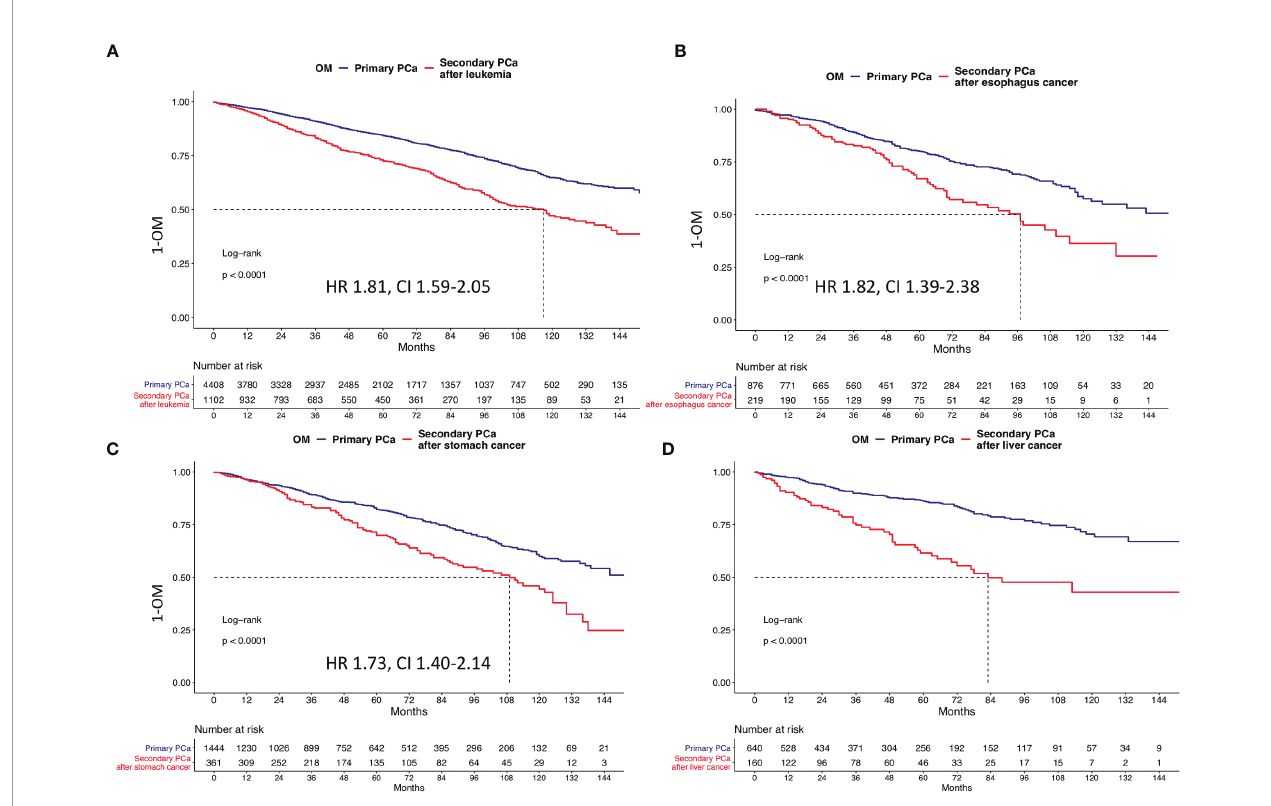
FIGURE 4 | Kaplan-Meier plots depicting overall mortality (OM) for primary and secondary prostate cancer after (A) primary leukemia, (B) primary liver cancer, (C) primary stomach cancer, and (D) primary esophagus cancer. HR, hazard ratio; CI, con fi dence